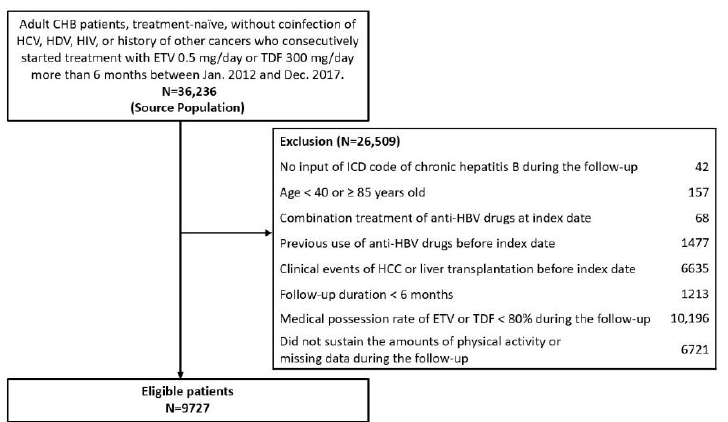
Figure 1. Flow diagram of the study population. Abbreviations: CHB, chronic hepatitis B; ETV, entecavir; HCV, hepatitis C virus; HIV, human immunodeficiency virus; TDF, tenofovir disoproxil fumarate.